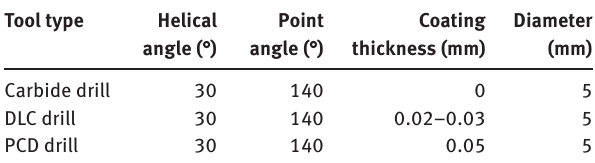
Table 1: Tool geometrical